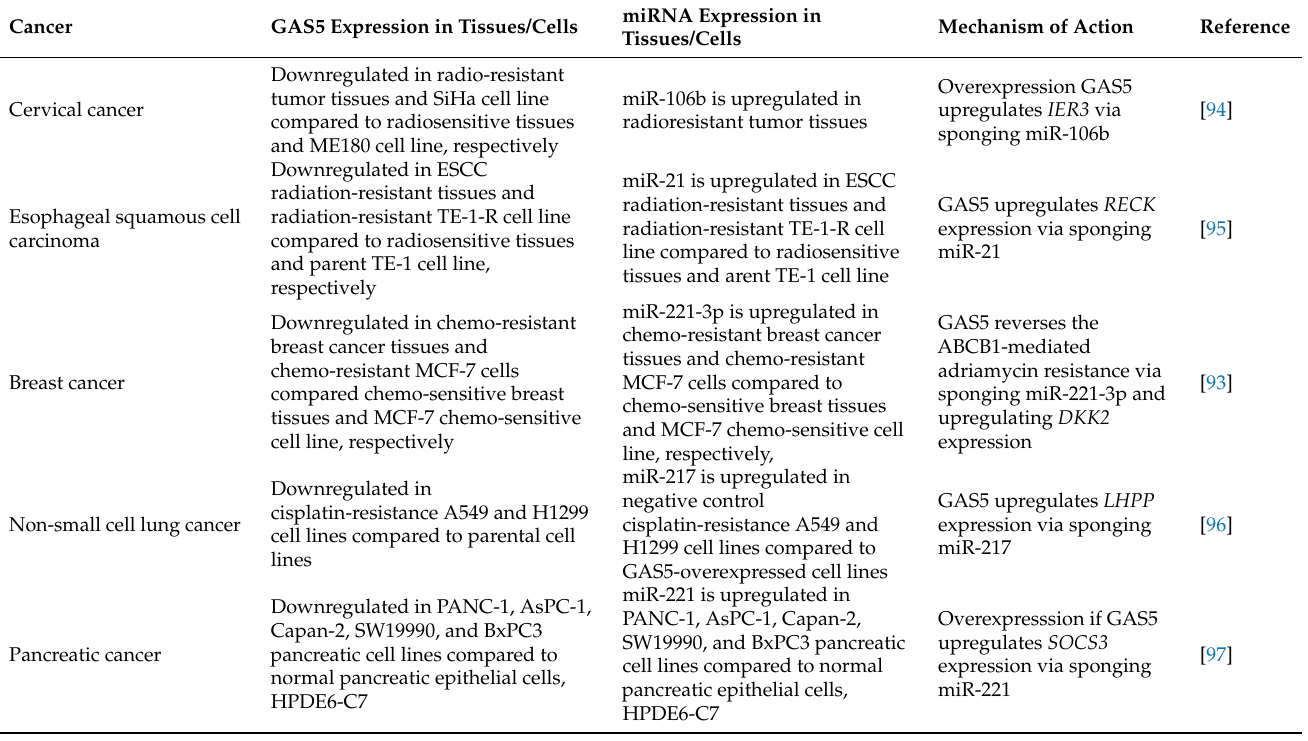
Table 3. GAS5 regulates chemosensitivity and radiosensitivity in cancer